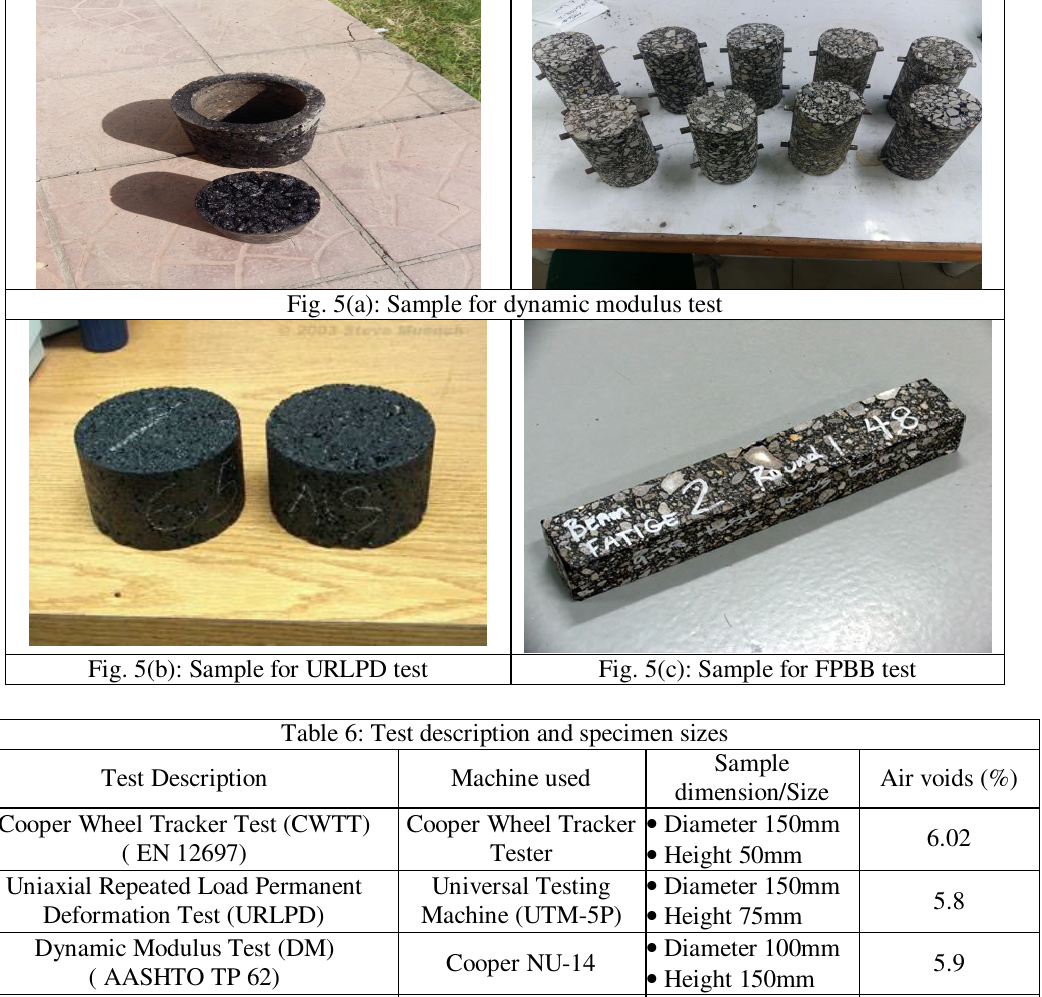
Fig. 5(a): Sample for dynamic modulus test